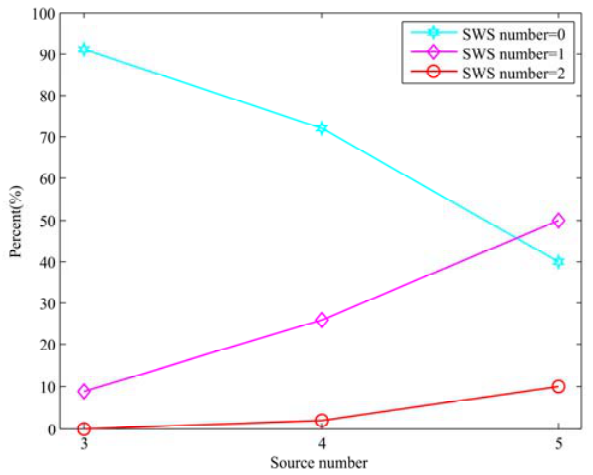
Figure 3. Statistical analysis for the existence of the SWS in Room 1.